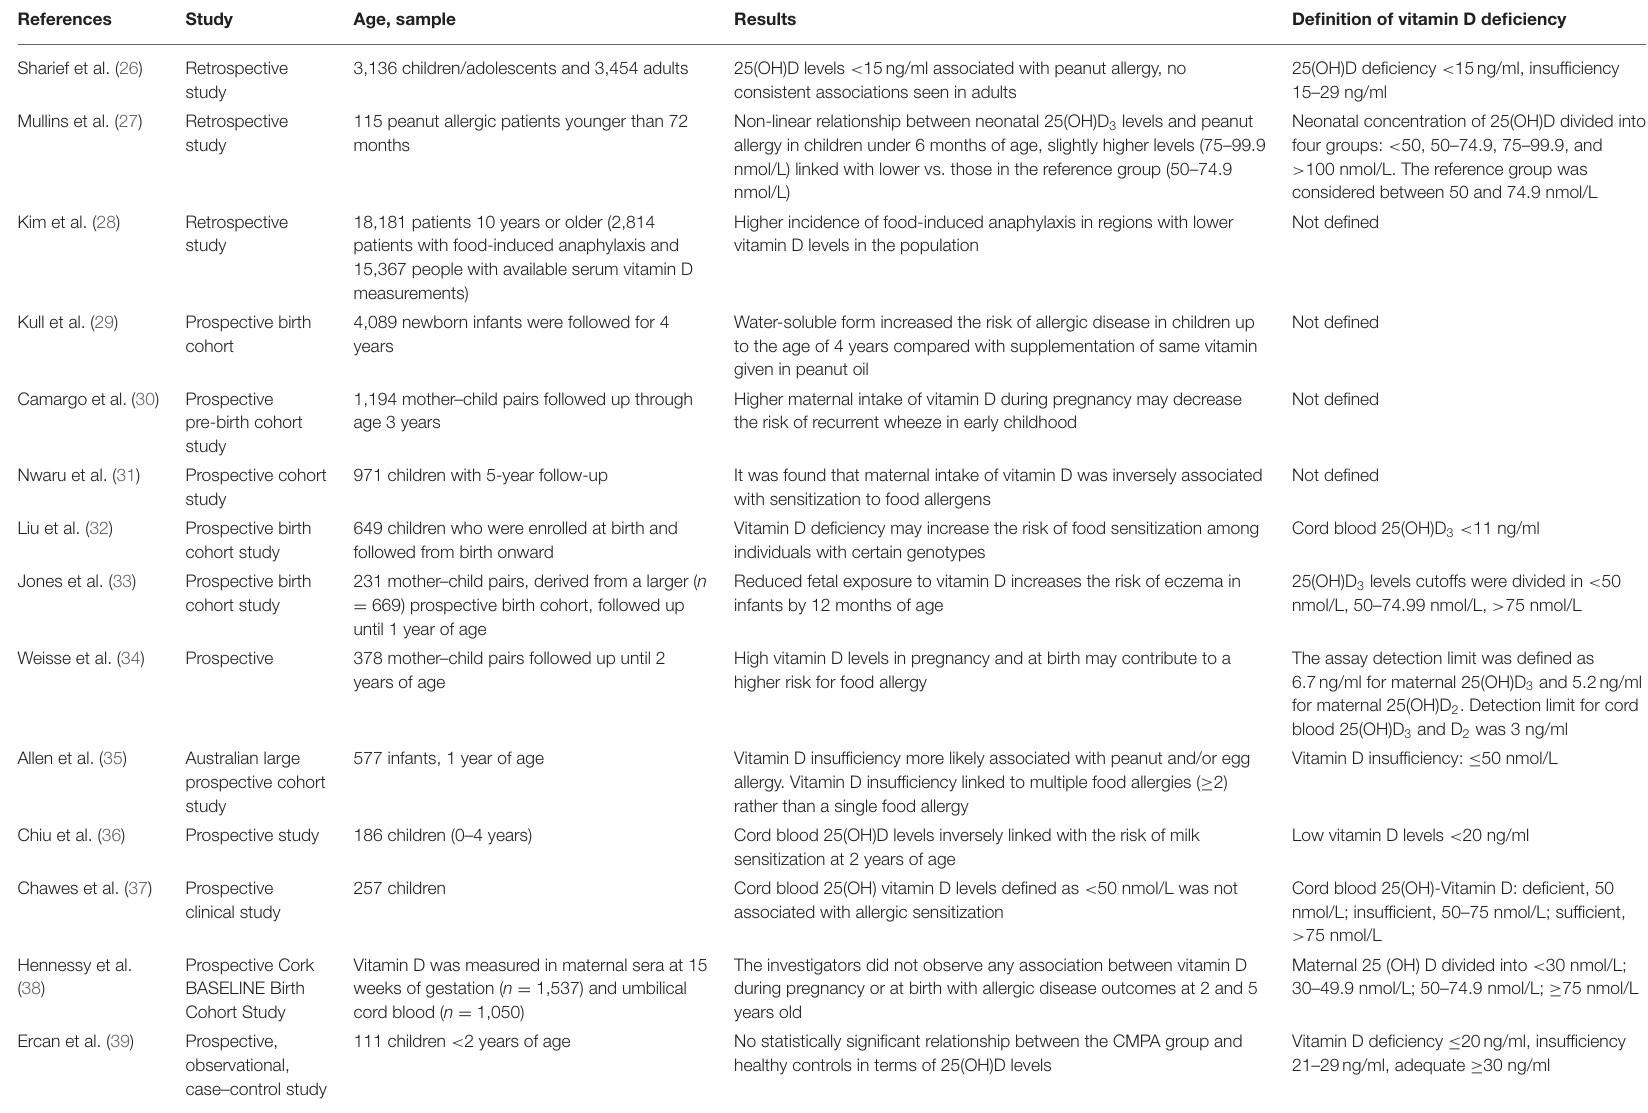
TABLE 1 | Summary of studies on the possible role of vitamin D in the development of food